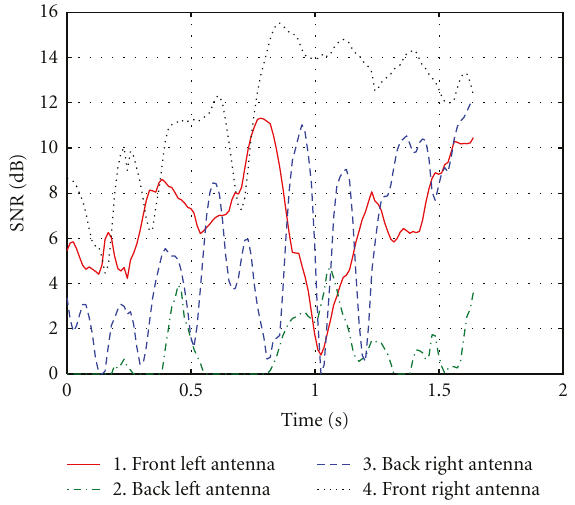
1. Front left antenna 2. Back left antenna Figure 5: SNR of signals received by the walking firefighter at 45 m distance from the transmitter (path 1, NLoS, 0 . 5 m/s)